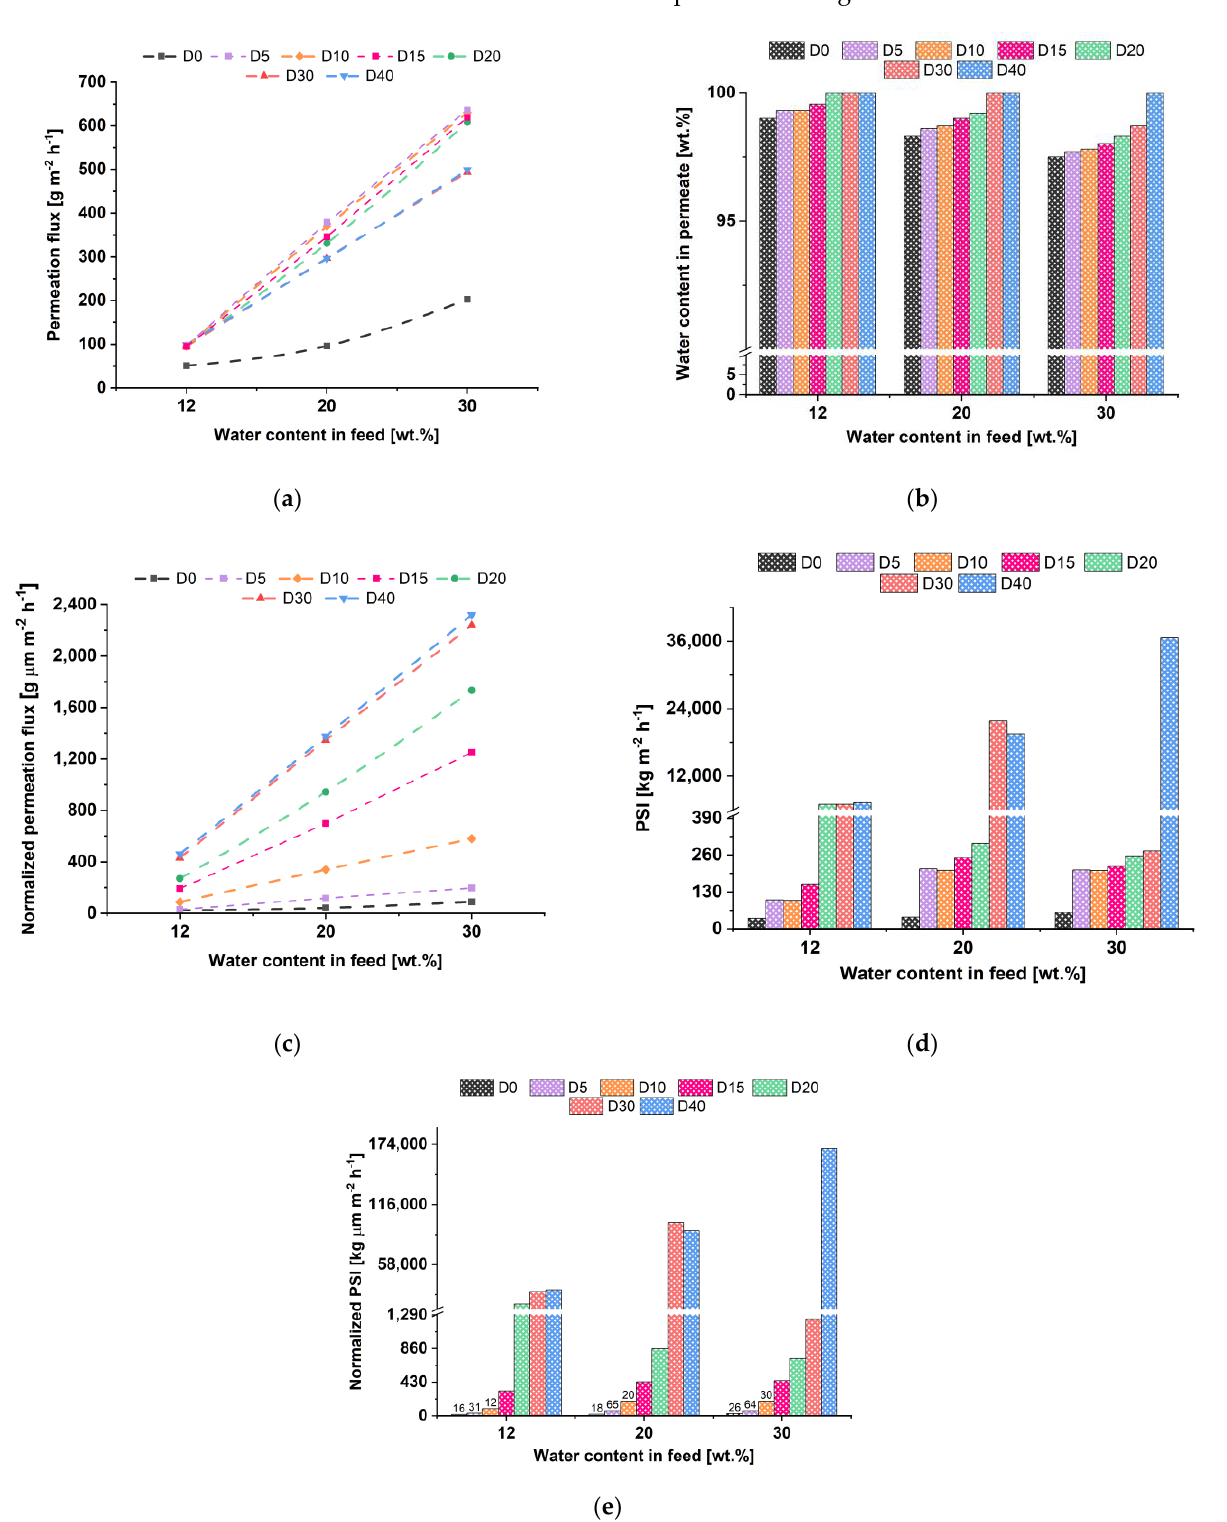
Figure 10. The dependence of permeation flux ( a ), water content in permeate ( b ), PSI ( c ), normalized permeation flux ( d ) and normalized PSI ( e ) of dynamic TFC membranes with different Fe-BTC concentration in the ChS selective layer on the water content in isopropanol/water feed